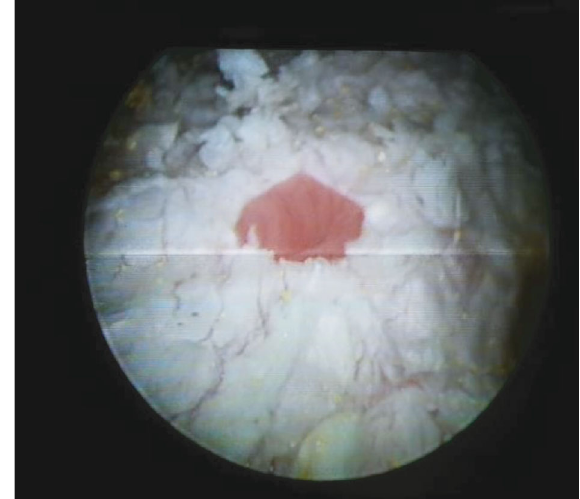
Figure 3: The mucosa underneath the plaques was in fl amed.